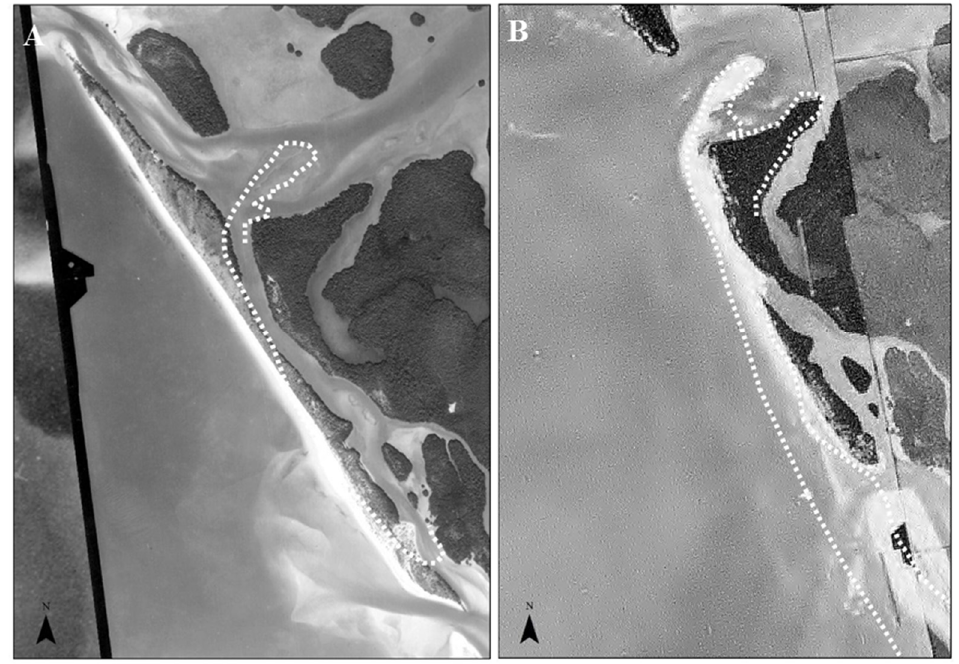
Figure 3. Morphologic changes of Big Hickory Island. ( A ) 1944 aerial photograph with the approximate 1958 shoreline shown as a white dashed line; ( B ) 1958 aerial photograph with the approximate 1980 shoreline shown as a white dashed line.